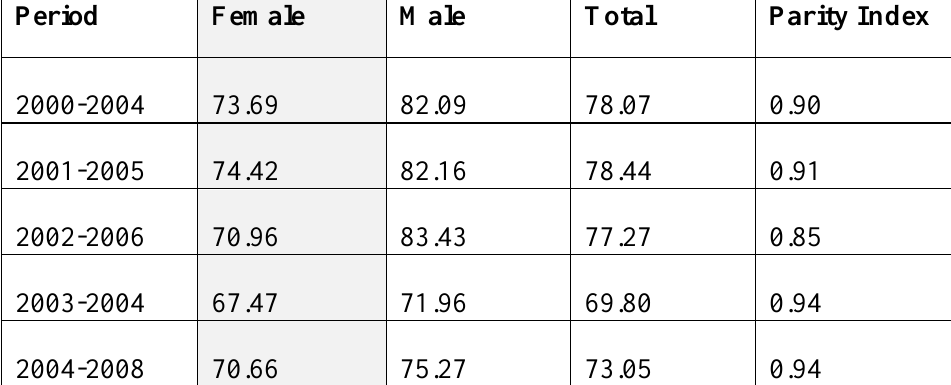
Table 3.1 Secondary School Completion Rate, Form 1 to Form 4, by sex and parity index, Zimbabwe 2004-2008